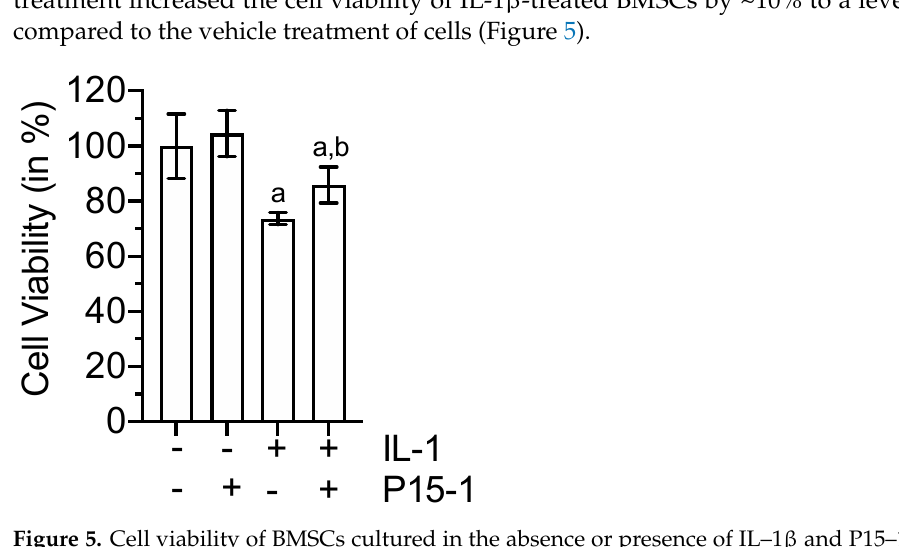
Figure 6. Numbers of human BMSCs attached to tissue culture dish (control), HMWHA–coated tis- sue culture dish (HMWHA), and tissue culture dish coated with HMWHA together with P15–1 (HMWHA/P15–1) after 20 min incubation of a suspension containing 1 × 10 5 cells at 37 °C. The num- ber of crystal violet stained cells attached to the dishes was counted. Data are presented as mean ± SD from three different experiments. a p < 0.01 vs. control; b p < 0.01 vs. HMWHA.